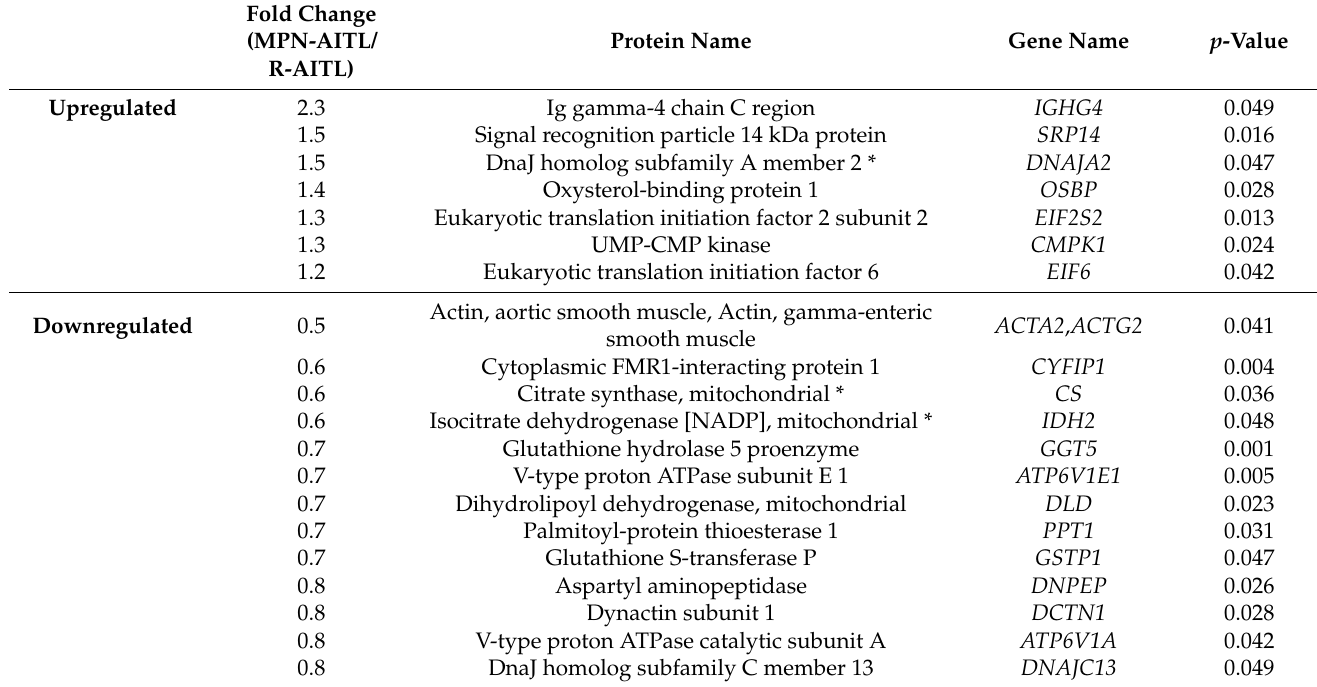
Table 2. Differentially expressed proteins between MPN-AITL and R-AITL